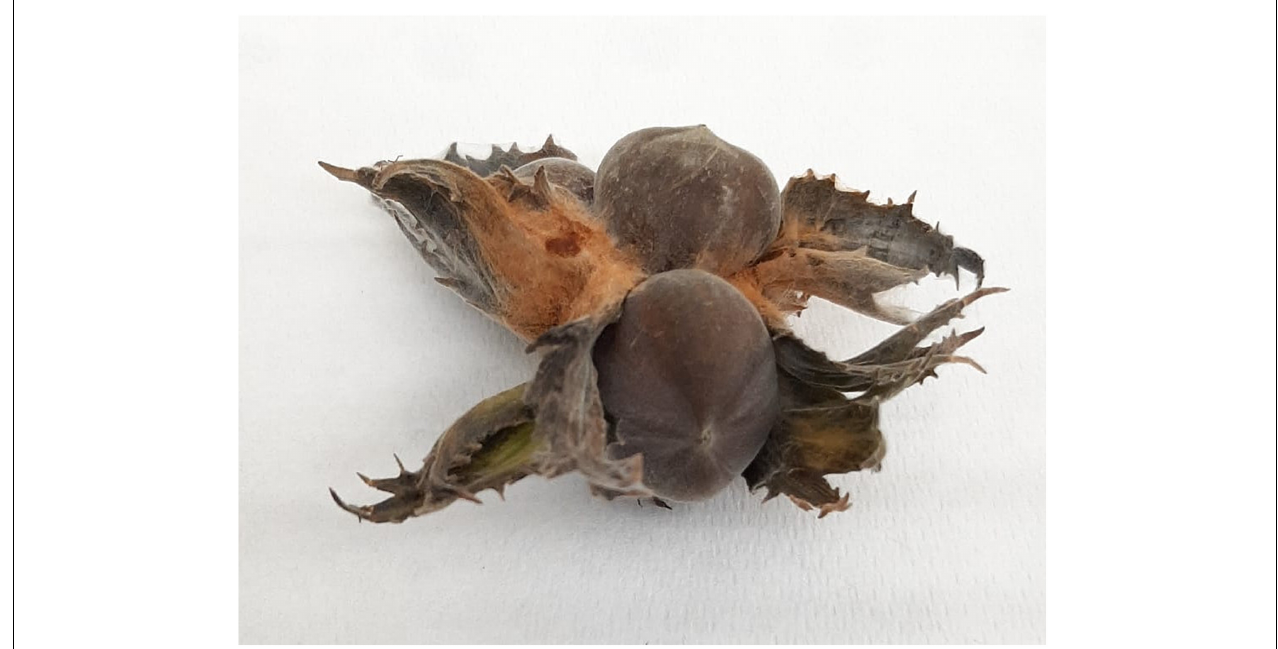
FIGURE 2 | Pathogen reinoculation. The isolated pathogen was reinoculated in healthy hazelnuts, which soon developed the same symptoms as the hazelnut collected in the field close to the Viterbo area (VT), confirming the Kock’s postulate.